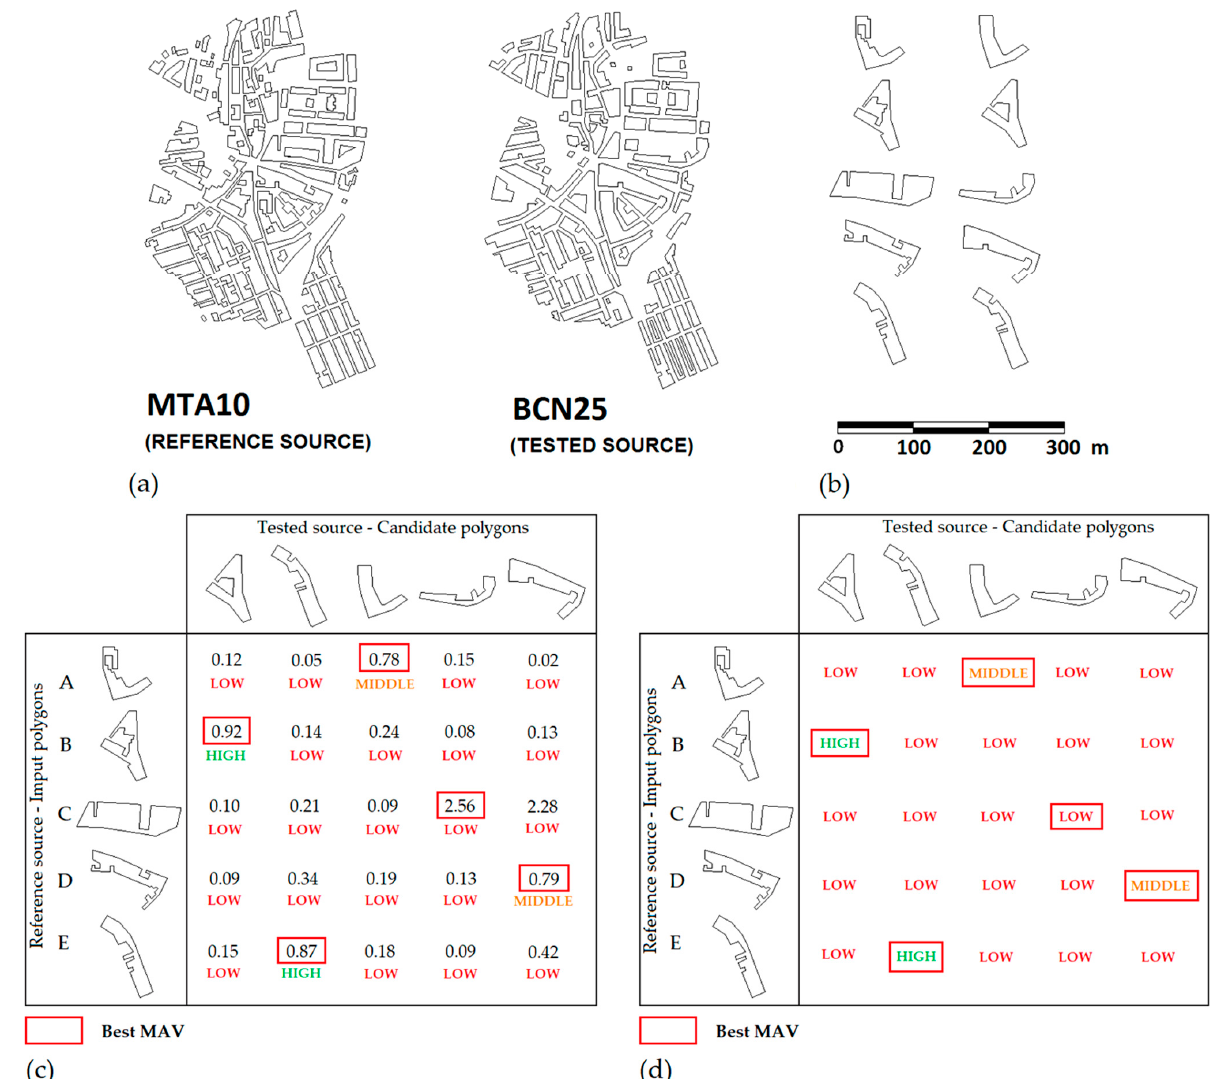
Figure 8. ( a ) Distribution of polygons according to the MAV computed by the group of experts, ( b ) percentage distribution of matched polygons for each level of MAV grouped by number of vertexes.